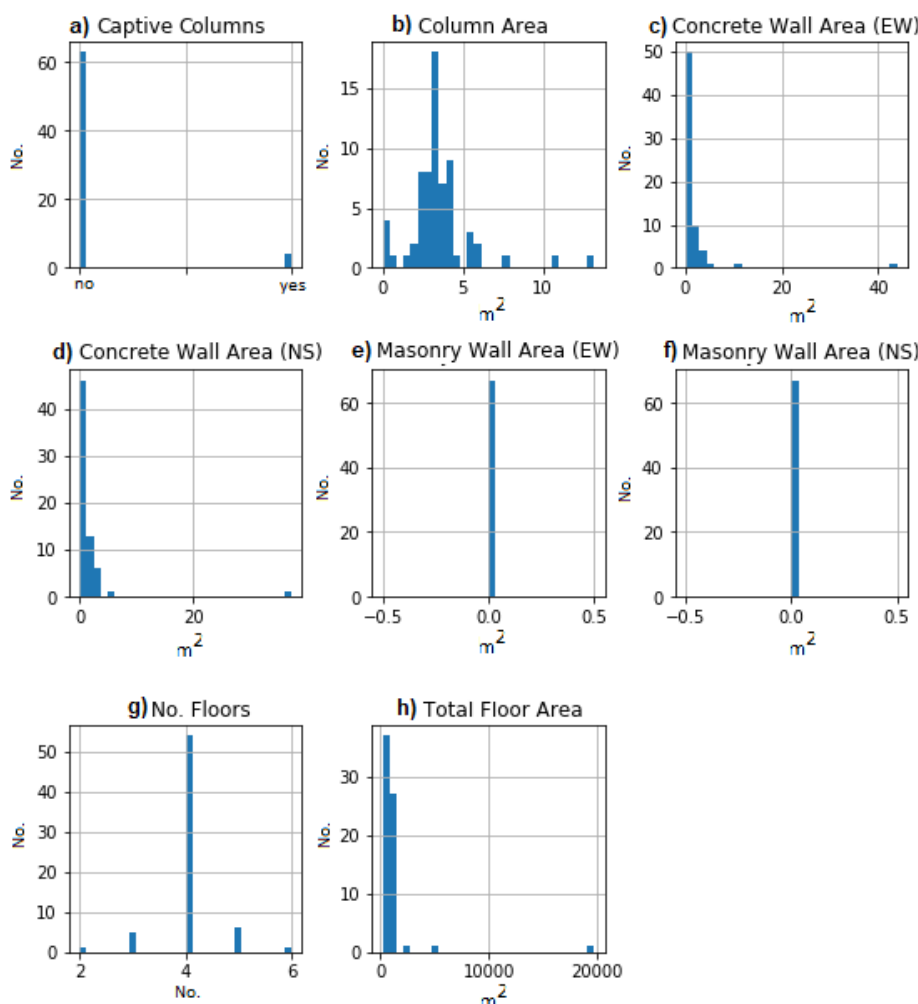
Figure 7. Data distribution of ( a ) Captive Columns, ( b ) Column Area, ( c ) Concrete Wall Area (EW), ( d ) Concrete Wall Area (NS), ( g ) No. of Floor, and ( h ) Total Floor Area for